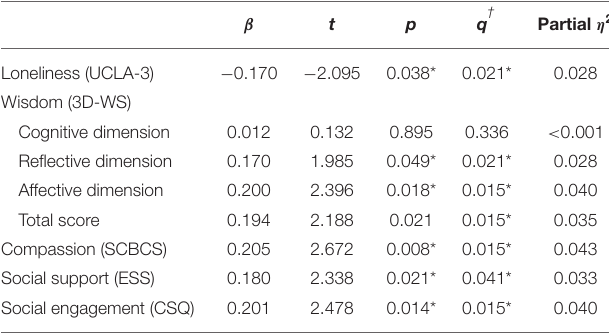
TABLE 2 | Coefficients from univariate linear regression models of each psychosocial factor predicting alpha-diversity (Faith’s Phylogenetic Diversity), after controlling for age and body mass